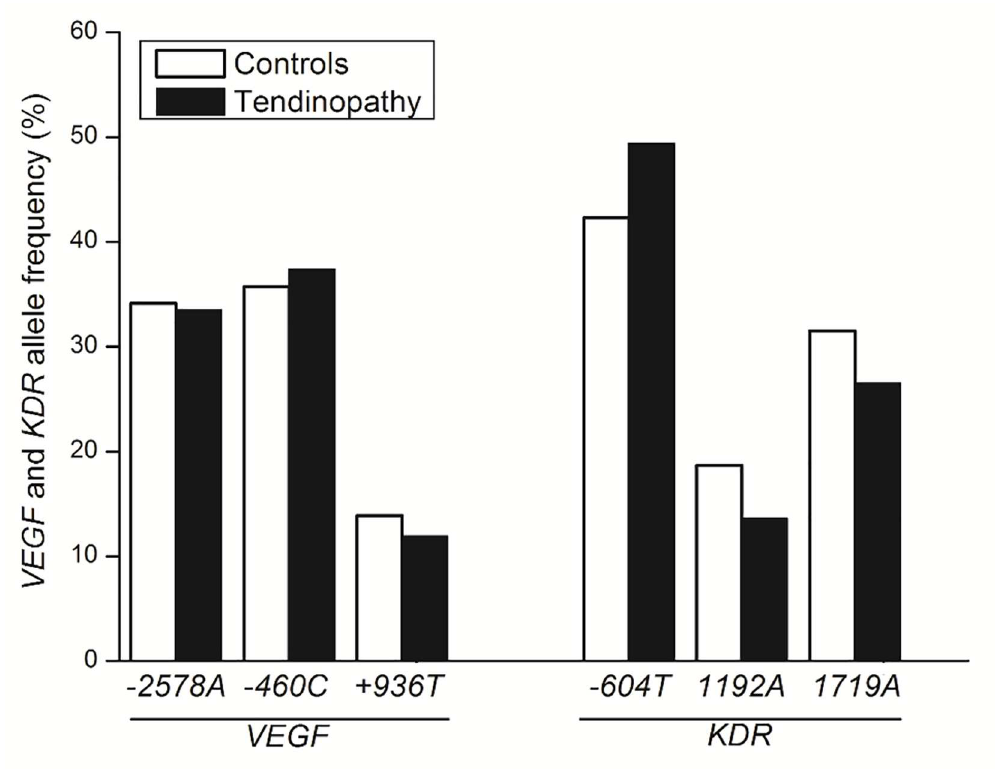
Fig 1. Allelic frequency of VEGF and KDR polymorphisms in tendinopathy cases and